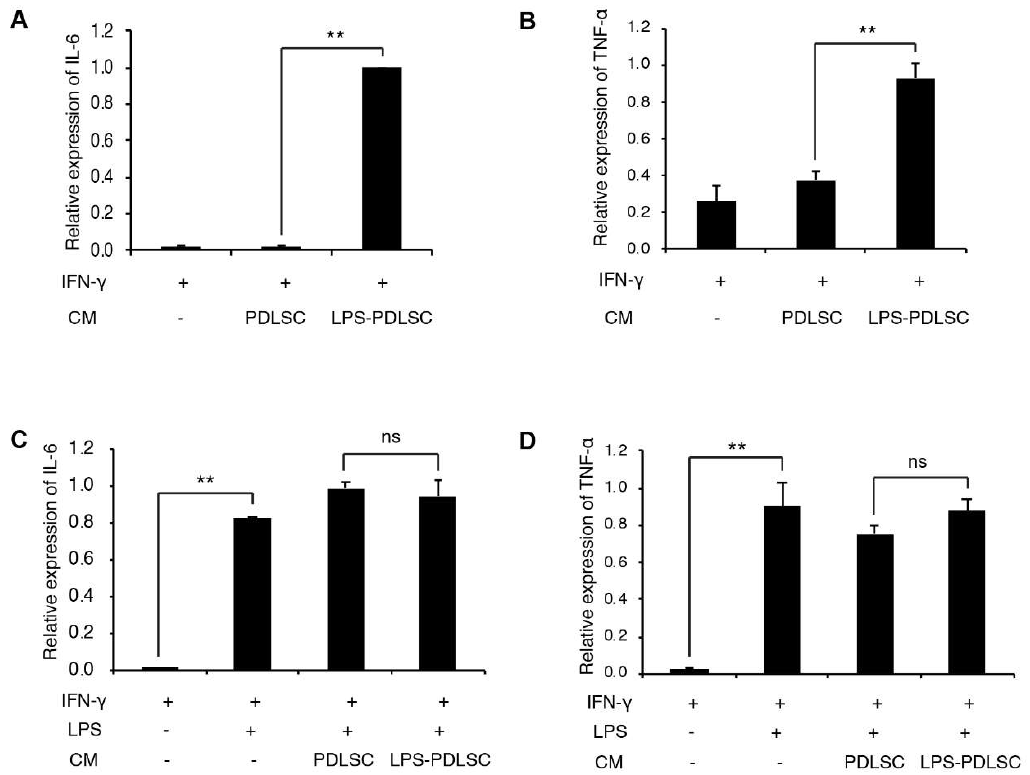
Figure 3. Effect of PDLSCs or LPS-preconditioned PDLSCs on the polarization of THP-1 cells with M1 stimulating agents. The conditioned media from PDLSCs or LPS-preconditioned PDLSCs were added to M0 THP-1 cells with interferon (IFN)- γ ( A , B ) or IFN- γ /LPS ( C , D ). Relative mRNA expression of IL-6 ( A , C ) and TNF- α ( B , D ) were analyzed by RT-qPCR. CM: Conditioned medium, IFN- γ : 20 ng/mL of IFN- γ , LPS: 1 µ g/mL of LPS, PDLSC and LPS-PDLSC: the conditioned media from PDLSCs and LPS-preconditioned PDLSCs, respectively. Data shown as the mean ± SD, n = 3, ns: Not significant, ** p < 0.01.